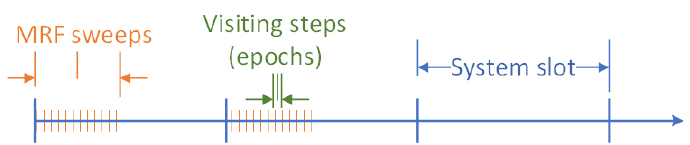
Figure 4. Relation of system slots, sweeps and update